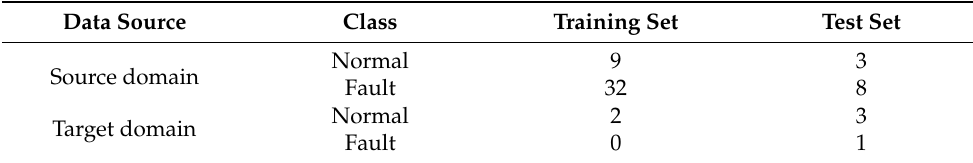
Table 4. Source and target domain data set partitioning for multi-machine